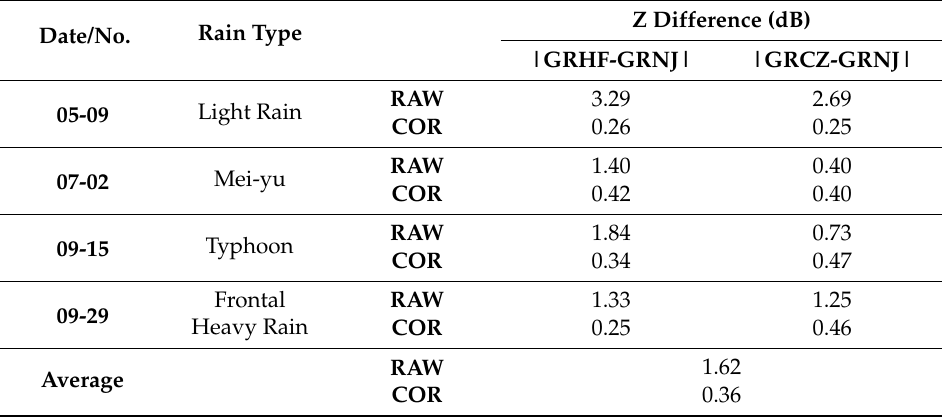
Figure 8. Raw reflectivity profile ( a , c ) and corrected reflectivity profile ( b , d ) for 2016-09-29 precipitation event. ( a , b ) Average reflectivity in GRHF and GRNJ overlapping area. ( c , d ) Average reflectivity in GRNJ and GRCZ overlapping area. Table 1. Reflectivity differences in overlapping areas of adjacent GRs.